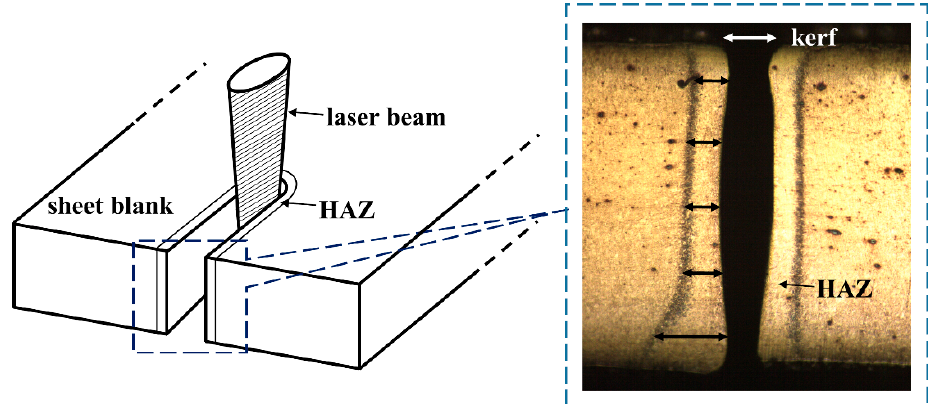
Figure 3. Schematic view and optical cross section of a linear laser cut. Five different positions (refer to the black arrows on the right-hand image) have been measured to compute HAZ width. Drawing not to scale.